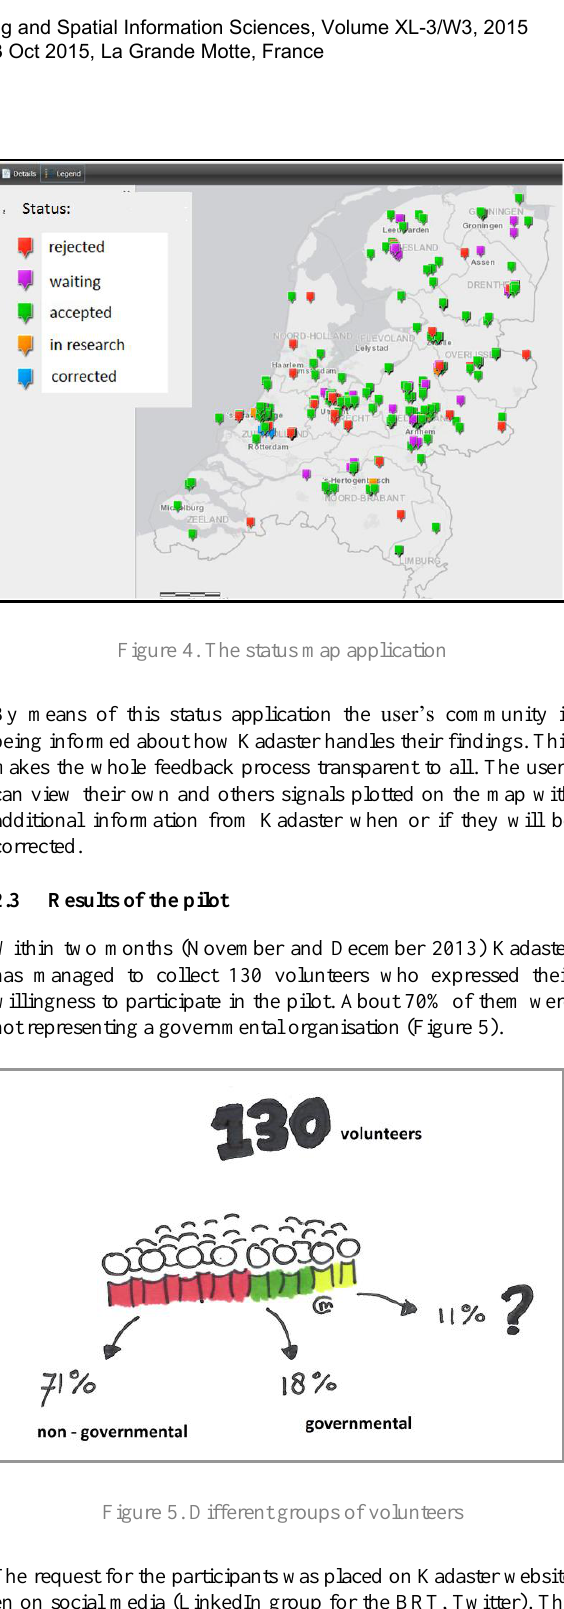
Figure 3. Feedback process flow during the pilot